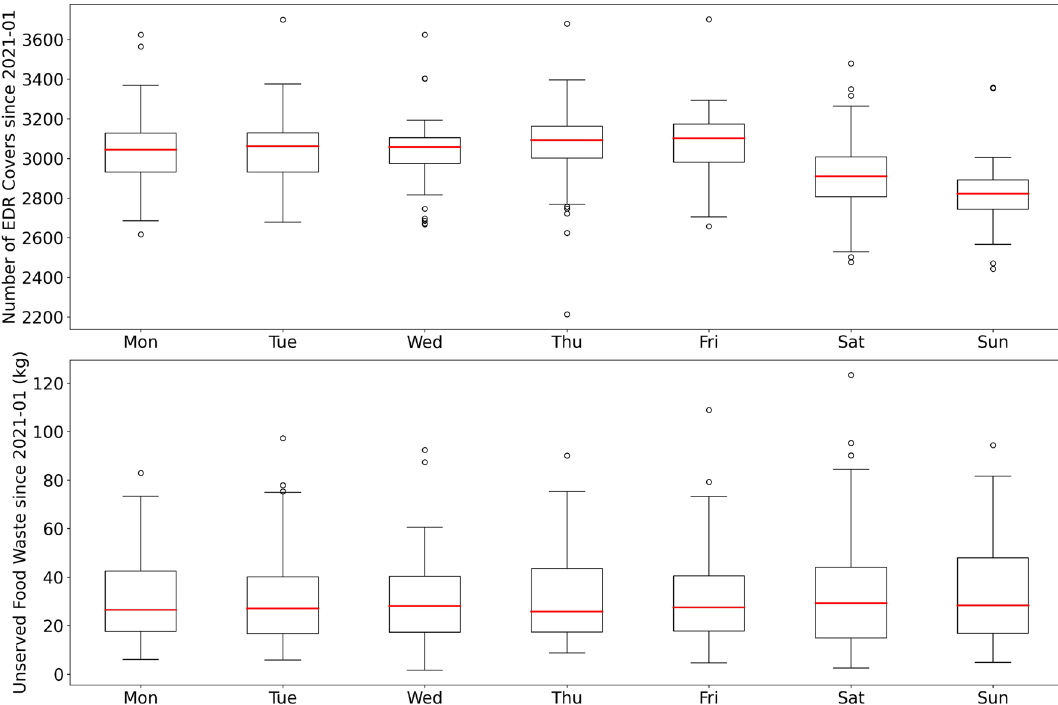
Figure 4. A box plot showing the staff cafeteria number of covers (top) and the weight of unserved food waste (bottom) for different days of the week. The bottom of the box is the lower quartile Q1 (25% of data below this value), the top of the box is the upper quartile Q3 (75% of data below this value), with a line at the median Q2 (50% of data below this value). The whiskers below and above the box extend no more than 1.5 × IQR (IQR = Q3–Q1) from the edges of the box, ending at the farthest data point within that interval. Outliers are plotted as